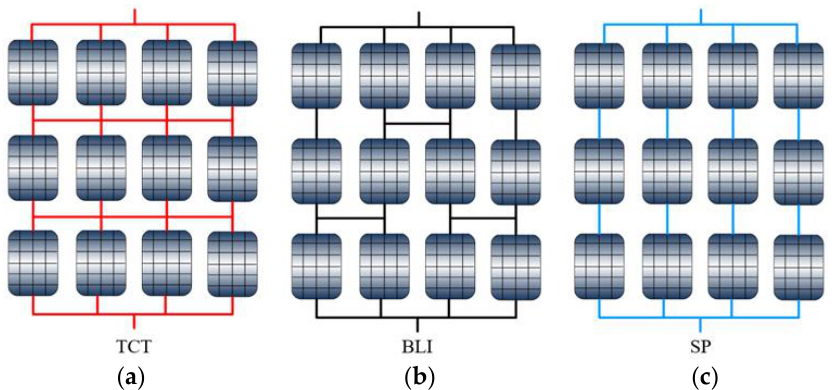
Figure 1. The fundamental formats of photovoltaic (PV) array linking are ( a ) total cross-tied (TCT), ( b ) bridge-link interconnection (BLI) and ( c ) series-parallel (SP).